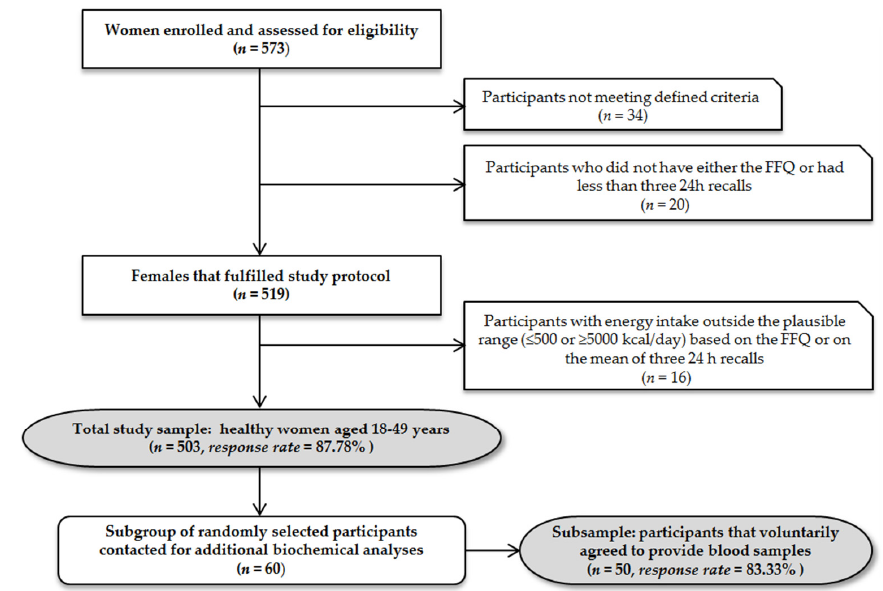
Figure 1. Recruitment process and sample overview (FFQ, Food Frequency